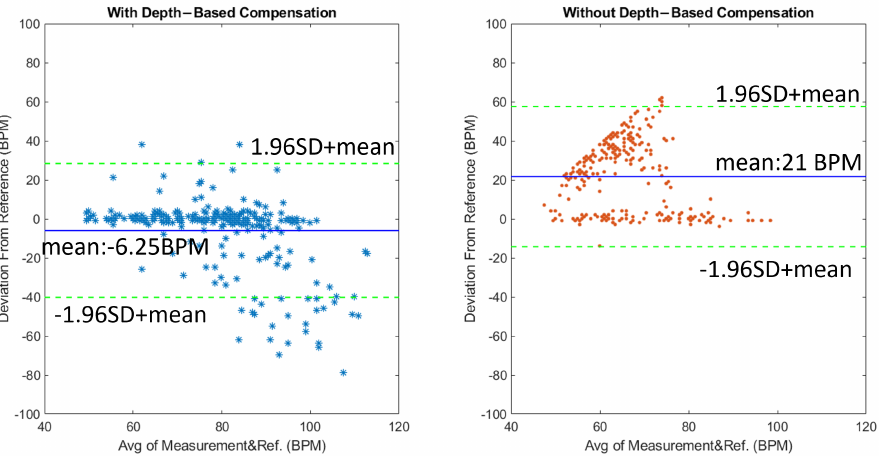
Figure 11. Bland–Altman plot for HR measurements on all 286 measurements with motion compen- sation ( left ) and without motion compensation ( right